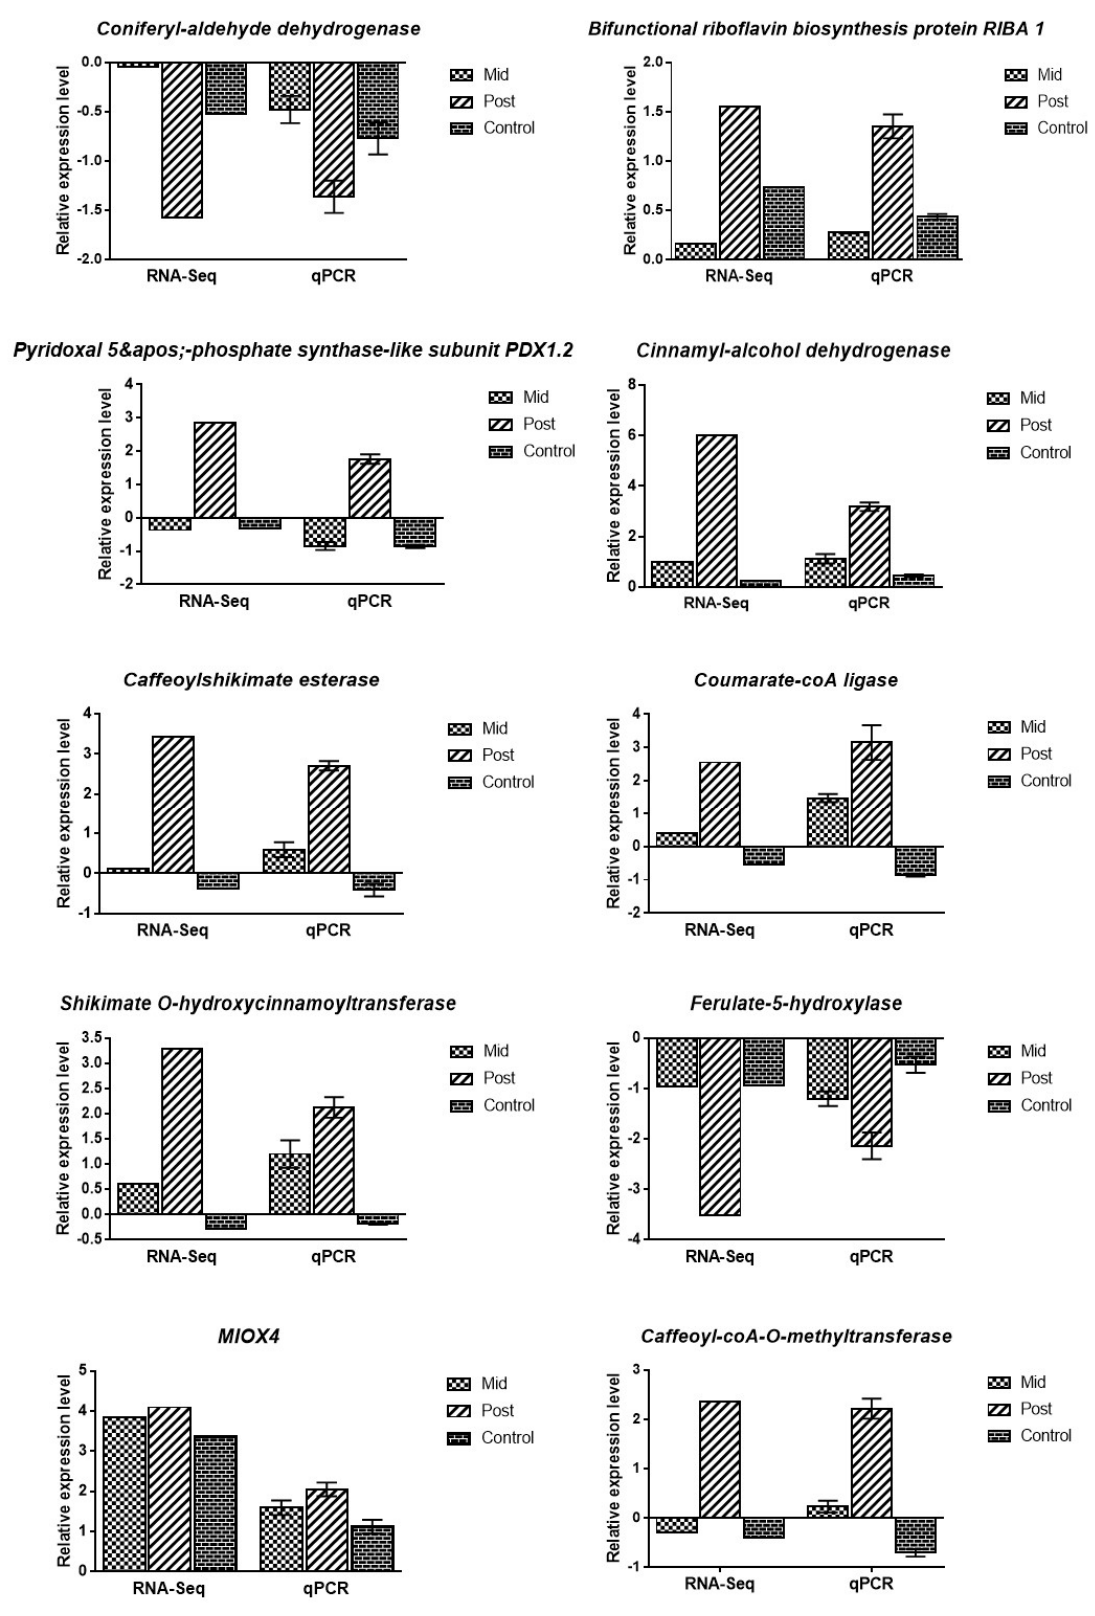
Figure 5. qRT − PCR analysis of ten representative genes for the confirmation of RNA − seq data. The bars on the qPCR data depict the means ± SD.